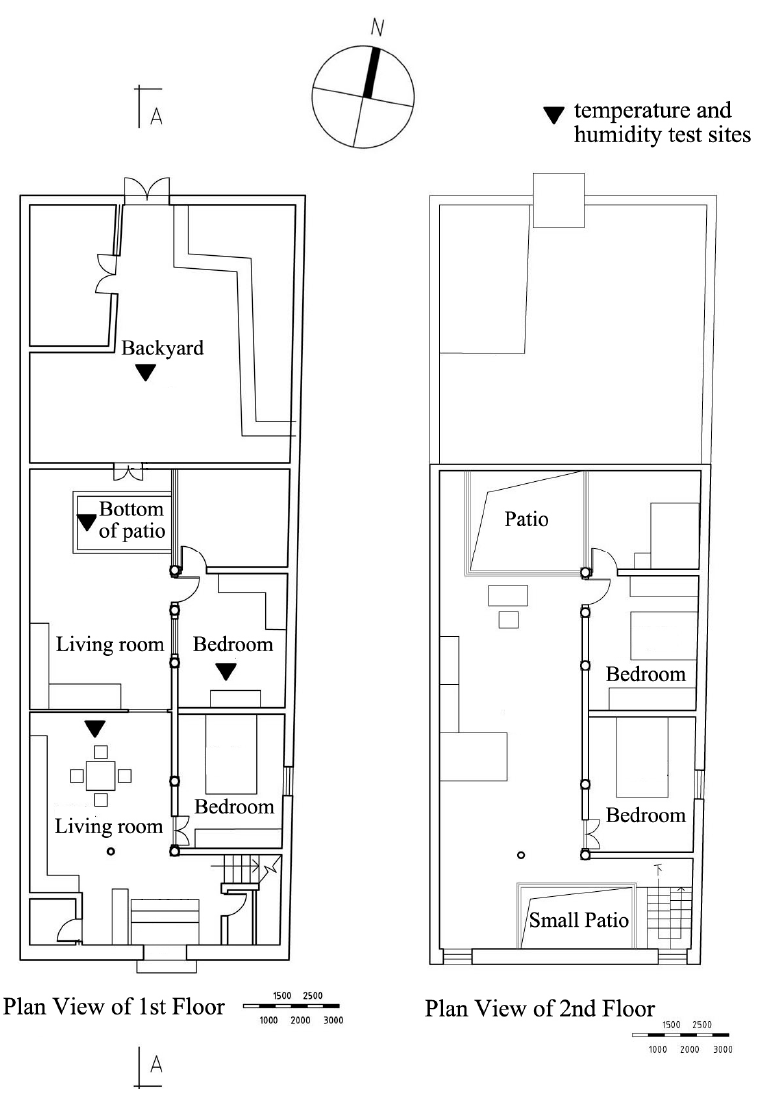
Figure 2. Plan view of “Yinzi” dwelling in Qianzhou, Western Hunan, China.